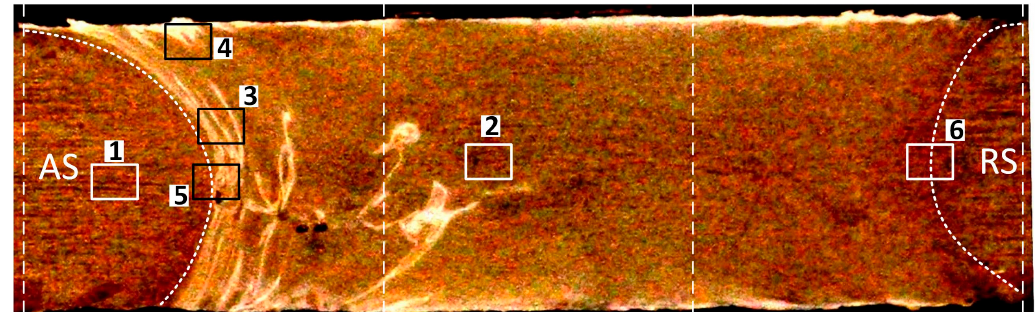
Figure 2. Weld cross-section of the AA6082-T6 plates, (1) Base Metal; (2) Middle Stirring Zone; (3) Flow-arms; (4) Sub-shoulder region; (5) Advancing Side (AS) Hourglass border and (6) Retreating Side (RS) Hourglass border. The two dashed-lines in the middle are representative of the position of the pin, the dashed-line in the corners of the cross-section are representative of the width of the shoulders.